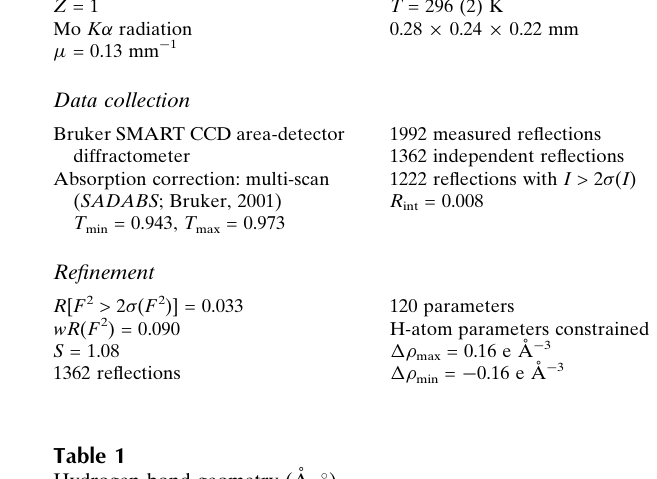
Hydrogen-bond geometry (A˚ , (cid:2)